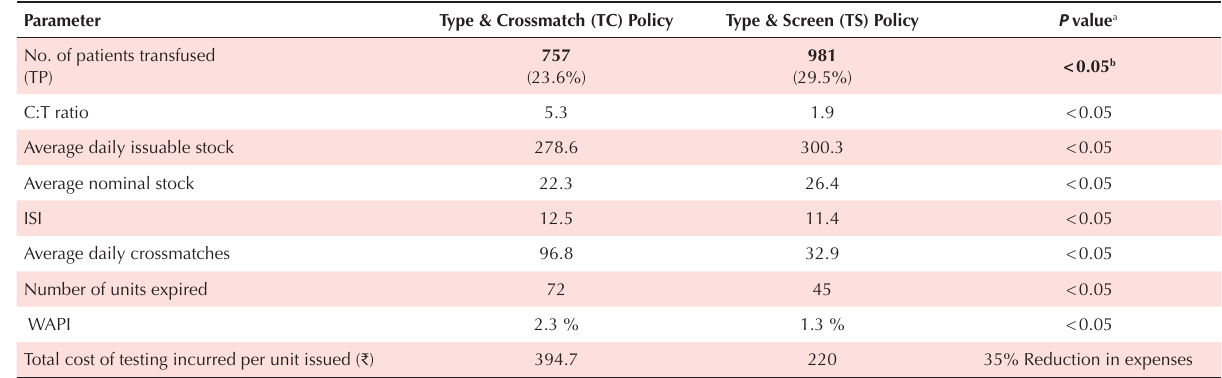
Table 2. RBC utilization